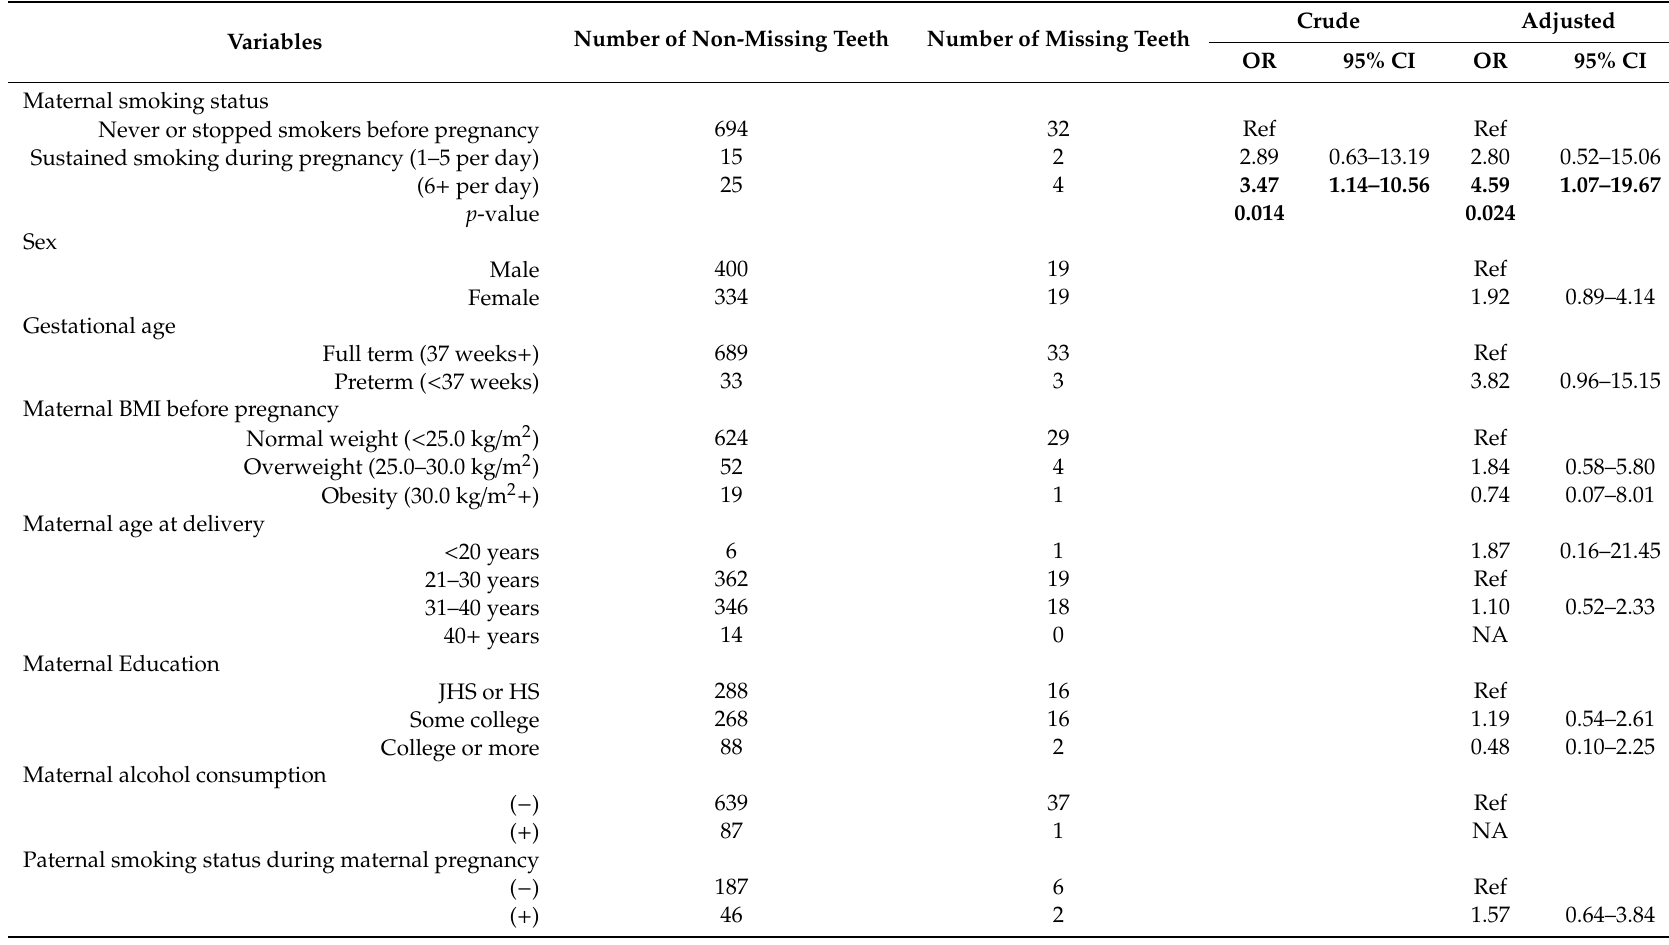
Table 2. Unadjusted and adjusted odds ratios for missing